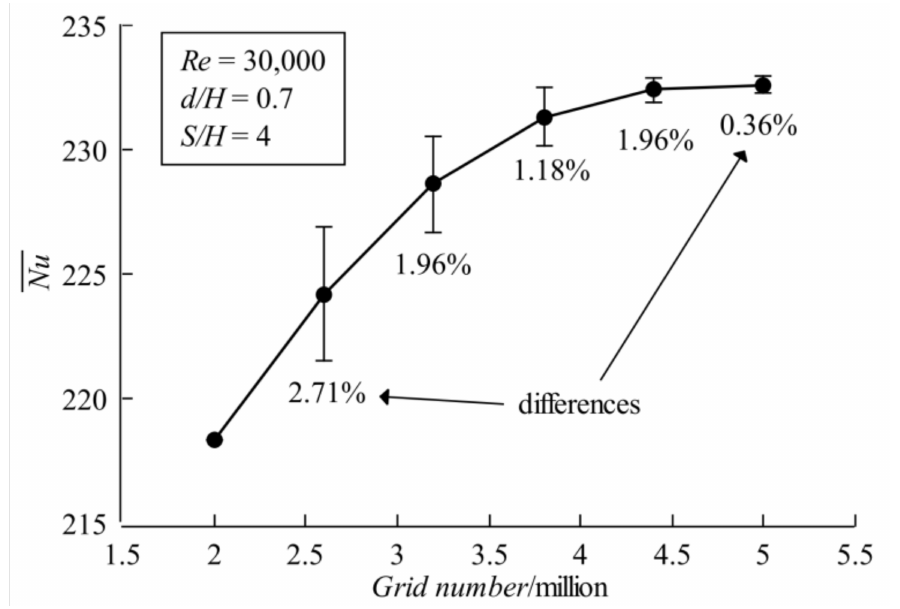
Figure 3. Verification of grid